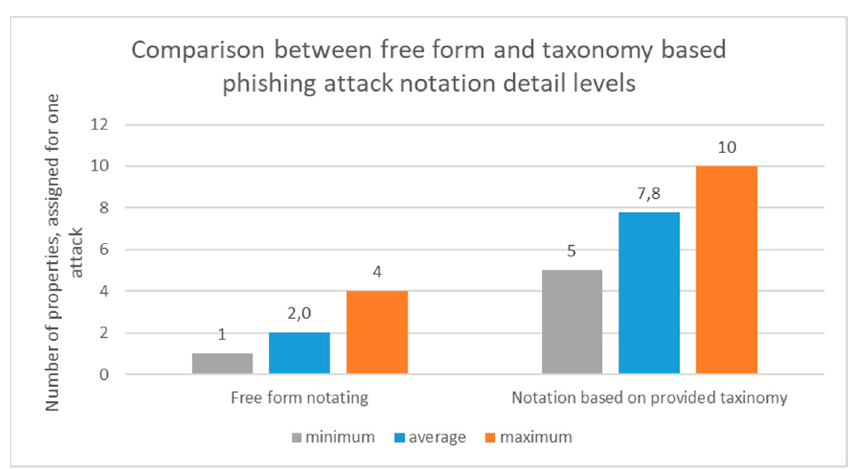
Figure 6. Comparison of phishing attack notation levels in free form and taxonomy-based phishing attack form.